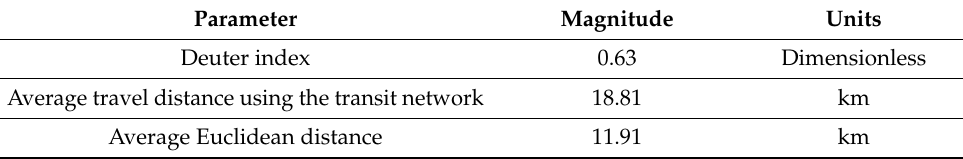
Table 3. Examples of the date generate calculating Deuter index.